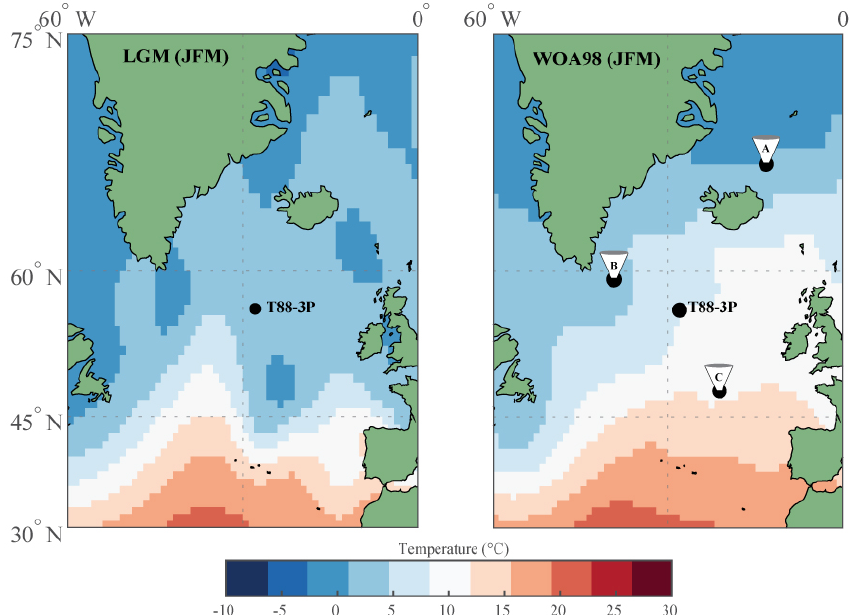
Figure 1. Map of North Atlantic study area with location of core T88-3P and the position of the sediment trap time series from the (A) Iceland Plateau (IP), (B) Irminger Sea (IRM) and (C) North Atlantic Bloom Experiment (NABE). Base maps represent the sea surface temperature for January–February–March of the Last Glacial Maximum, based on the Multiproxy Approach for the Reconstruction of the Glacial Ocean Surface (MARGO) database (Kuˇcera et al., 2005), and the modern ocean, based on World Ocean Atlas 1998 (as used by